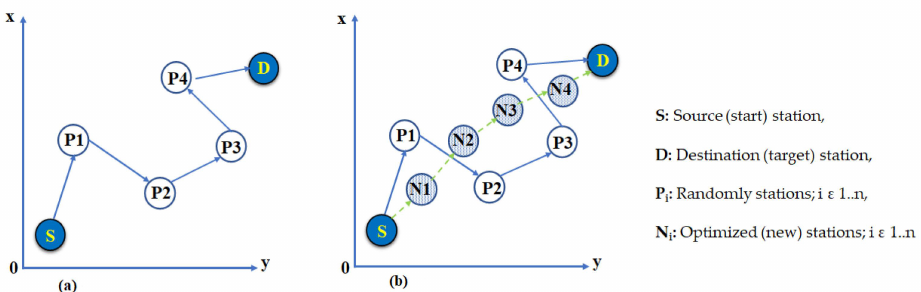
Figure 2. The randomly created and optimized trajectory. ( a ) Randomly Created Path; ( b ) Optimized Created